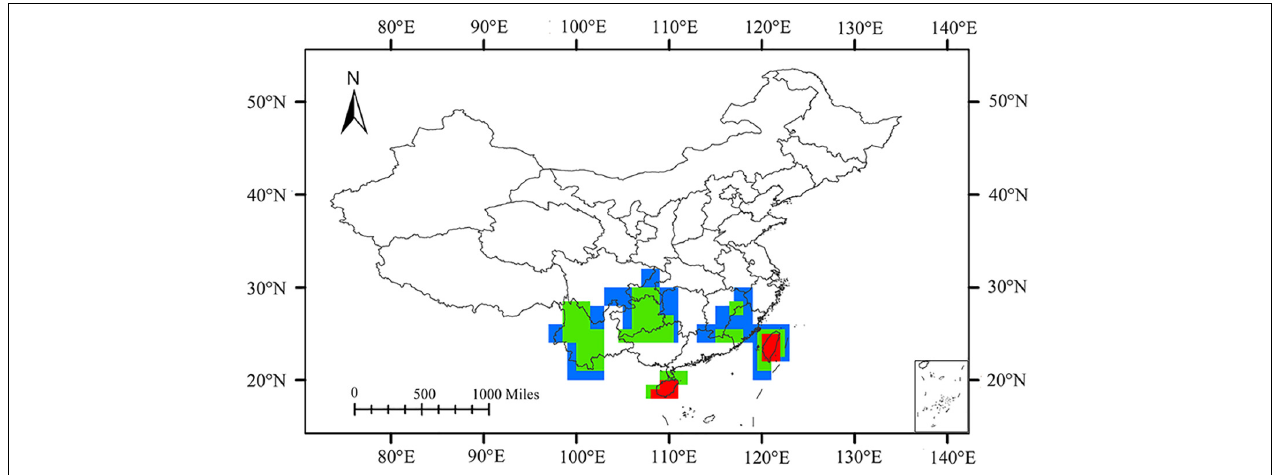
FIGURE 5 | Overlap of the consensus areas of endemism (AoEs) delimited for planthoppers by endemicity analysis (EA) employing 1 ◦ (red), 1.5 ◦ (green), and 2 ◦ (blue) grids in